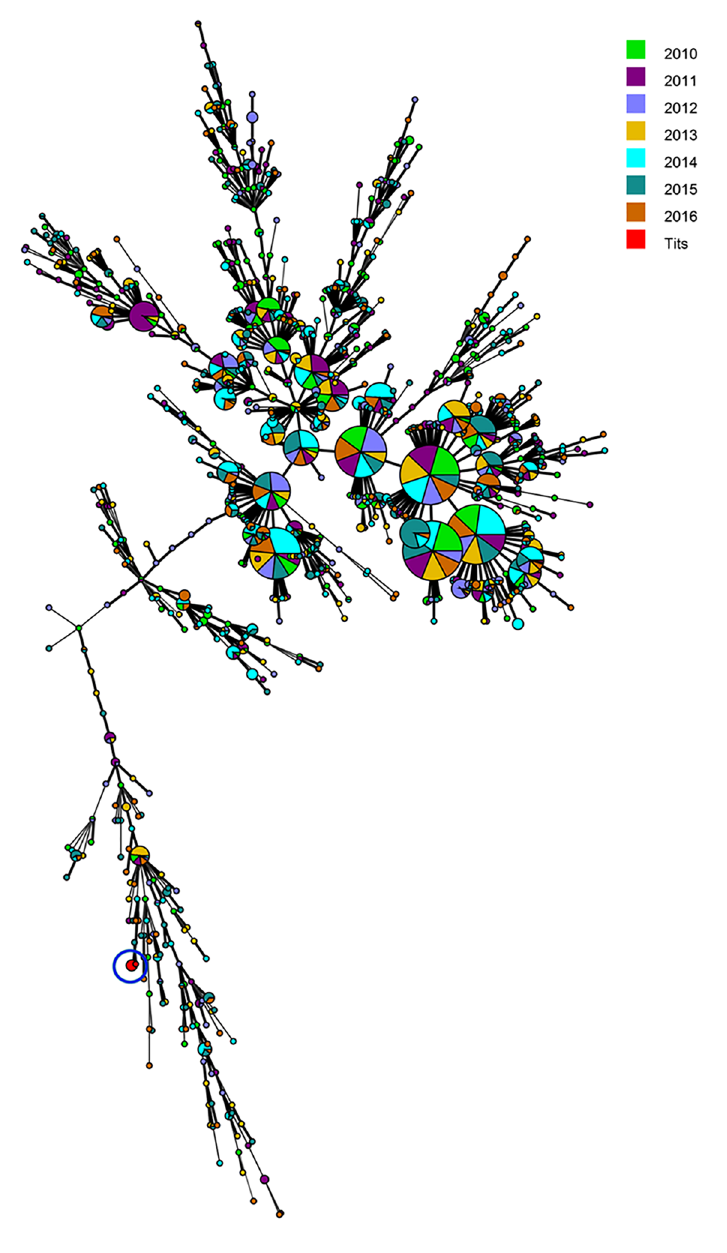
Fig 2. Minimum spanning tree based on MLVA data. Shownis a minimum spanning tree calculatedfor the MLVA profiles of the seven Salmonella Typhimurium isolates of blue and great tits, comparedwith 3239 Salmonella Typhimurium humanisolates, regardlessof phage type, in Belgiumover the periodof 2010–2016.